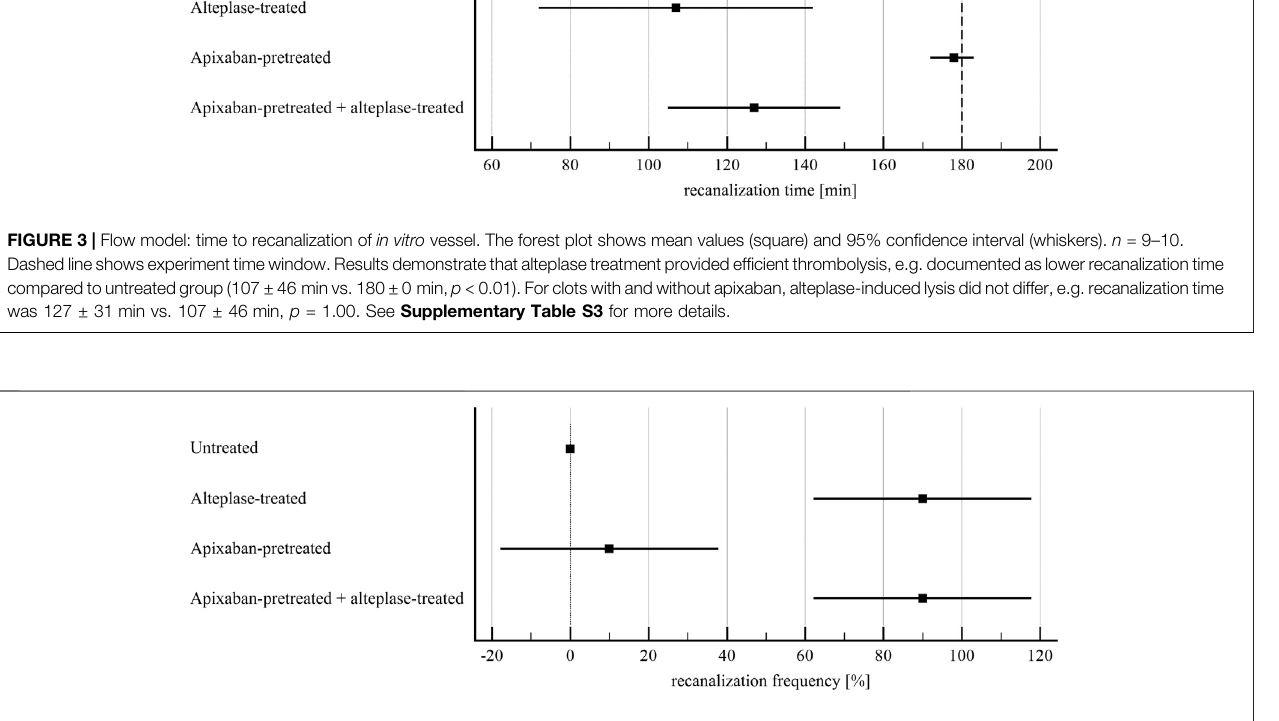
FIGURE 4 | Flow model: recanalization frequency of in vitro vessel. The forest plot shows mean values (square) and 95% con fi dence interval (whiskers). n (cid:1) 5. Results demonstrate that alteplase treatment provided ef fi cient thrombolysis, e.g. documented as greater recanalization frequency compared to untreated group (90 ± 22%vs.0 ± 0%, p < 0.01).Forclotswithandwithoutapixaban,alteplase-inducedlysisdidnotdiffer,e.g.,recanalizationfrequencywas90 ± 22%vs.90 ± 22%, p (cid:1) 1.00. See Supplementary Table S3 for more details.